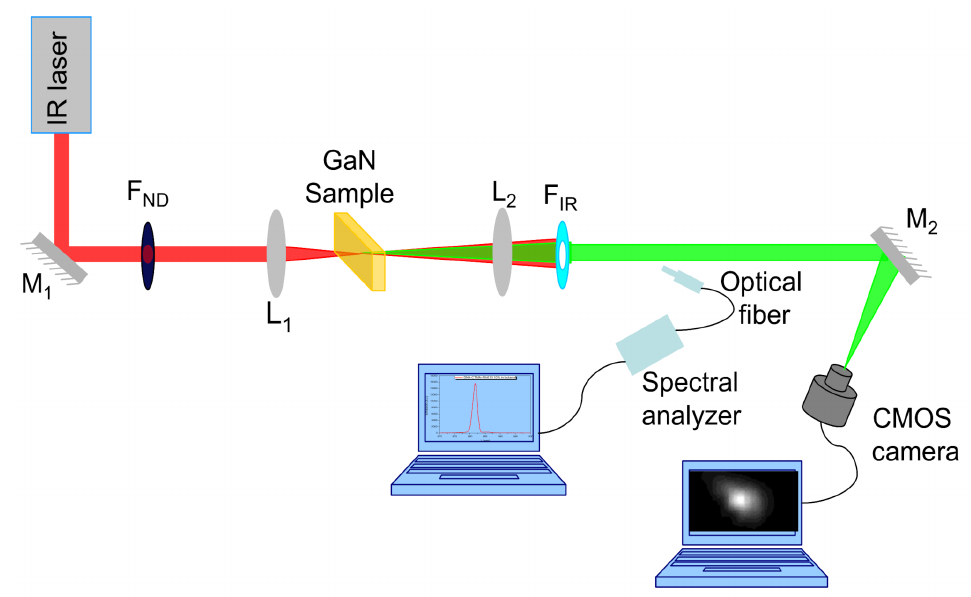
Figure 3. Schematic of the experimental setup used for THG in GaN